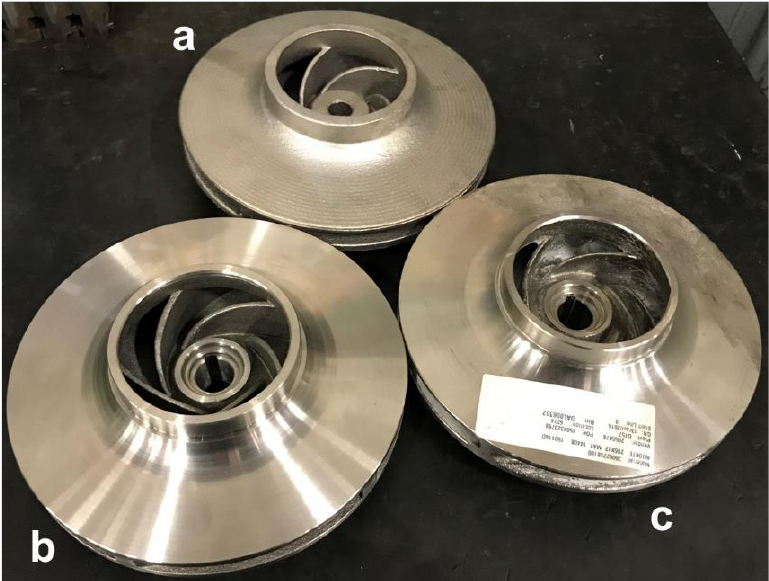
Figure 8. View of the final BJ impellers manufactured before ( a ) and after ( b ) machining finish. ( c ) Original KSB impeller.